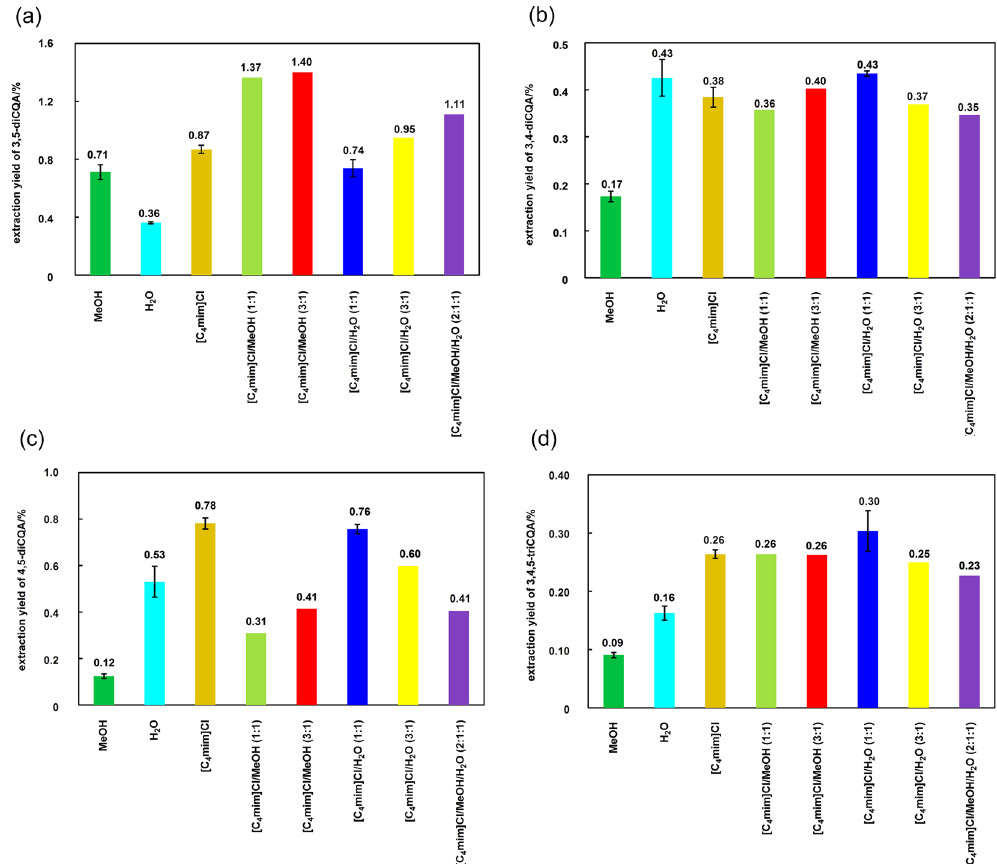
Figure 3. Extraction yields of ( a ) 3,4-diCQA, ( b ) 3,5-diCQA, ( c ) 4,5-diCQA, and ( d ) 3,4,5-triCQA. Experiments for MeOH (reflux), H 2 O (reflux), [C 4 mim]Cl (150 °C), and [C 4 mim]Cl/H 2 O (1:1 w/w, 120 °C) were performed three times and the average values are reported. Experiments for [C 4 mim]Cl/MeOH (1:1 w/w, 3:1 w/w, 100 °C), [C 4 mim]Cl/H 2 O (3:1 w/w, 120 °C), and [C 4 mim]Cl/MeOH/H 2 O (2:1:1 w/w/w, 100 °C) were carried out one